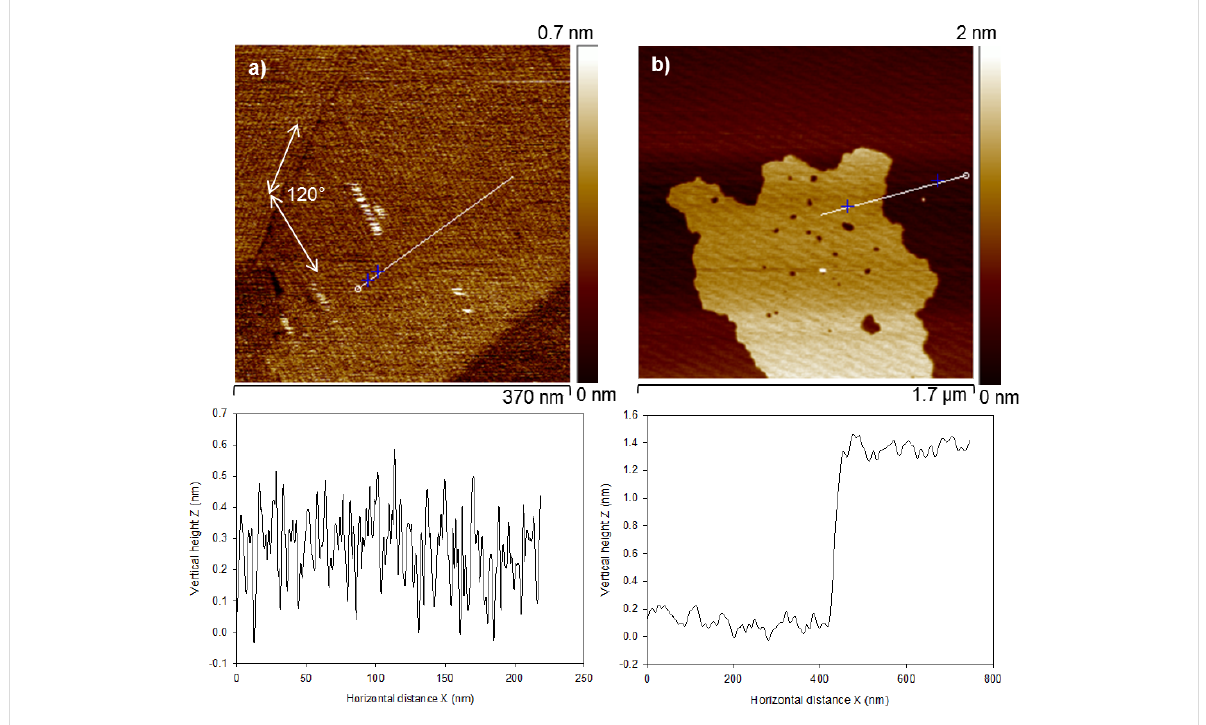
Figure 3: TM-AFM height images of DODA deposited on a) HOPG and b) mica. Corresponding cross-section analyses taken along the white lines are shown below each image.